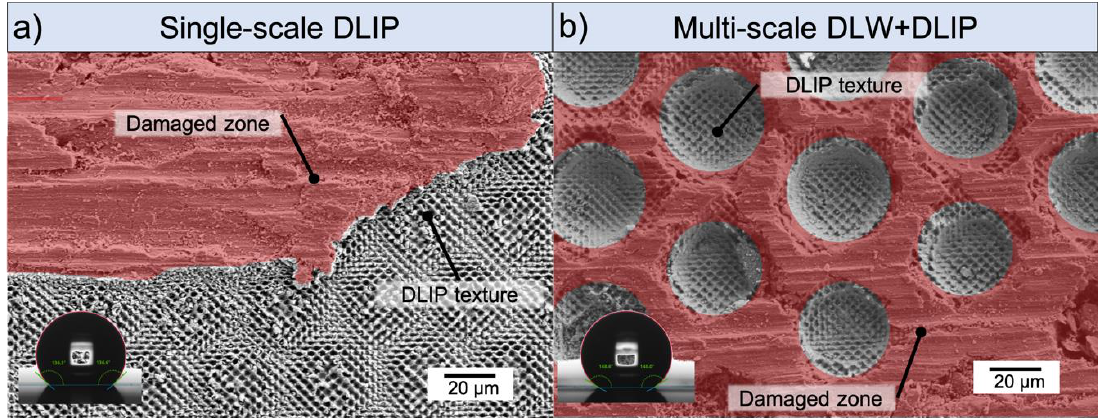
Figure 8. SEM images of wear tracks achieved by a ball-on-disk test on a single-scale DLIP 3.4µm deep texture ( a ) and on a multi-scale DLW + DLIP 3.4µm deep treated texture ( b ). The red colored areas indicate the damaged zone. The used 100Cr6 ball had a diameter of 6 mm and the normal load was kept constant at 0.5 N.